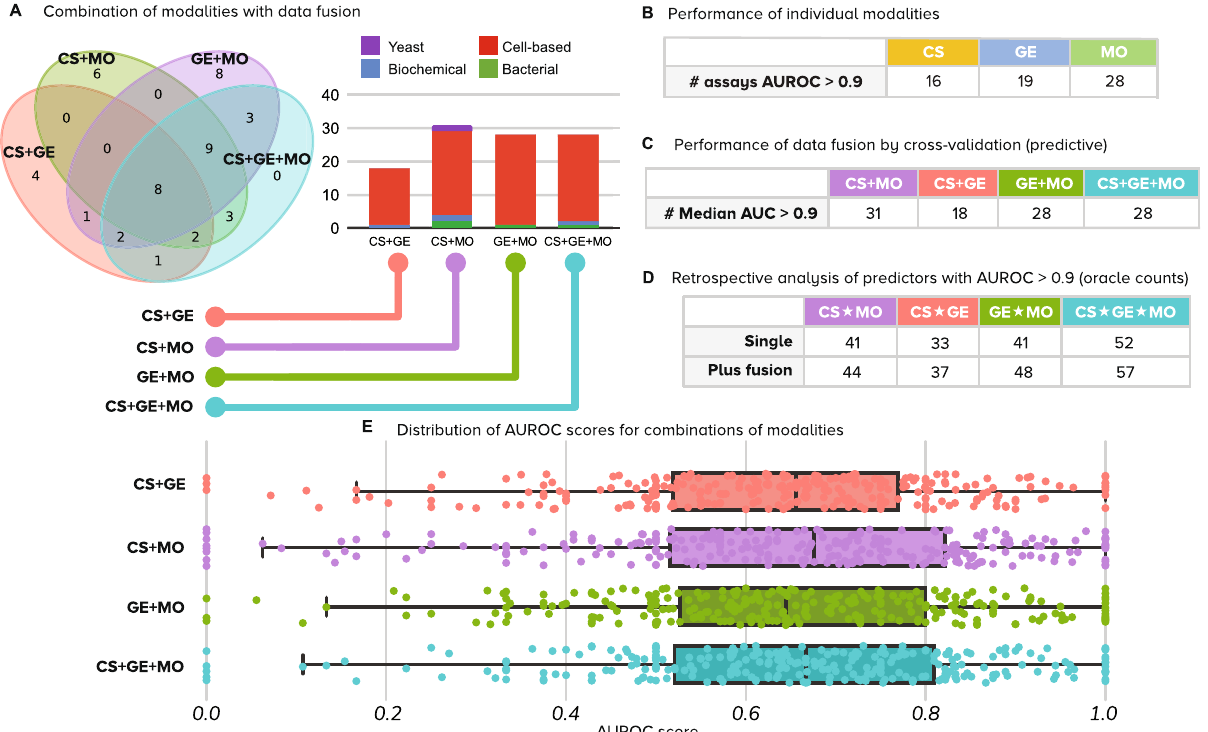
Fig. 3 | Number ofassays that can be accurately predicted using combinations of pro fi ling modalities. Accurate predictors are de fi ned as models with accuracy greater than 0.9 AUROC. We considered all four modality combinations using late datafusioninthisanalysis:CS+MO(chemicalstructuresandmorphology),CS+GE (chemical structures and gene expression), GE+MO (gene expression and mor- phology), and CS+GE+MO (all three modalities). A The Venn diagram shows the numberofaccuratelypredictedassaysthatareincommonoruniquetofused data modalities.Thebarplotsinthecentershowthedistributionofassaytypescorrectly predicted by the fused models. All counts are the median of results in the holdout set of a fi vefold cross-validation experiment. B Performance of individual mod- alities (same as in fi rst row of Fig. 2D). C The number of accurate assay predictors (AUROC>0.9) obtained for combinations of modalities (columns) using late data fusion following predictive cross-validation experiments. D Retrospective perfor- mance of predictors using oracle counts. These counts indicate how many unique assayscanbepredictedwithhighaccuracy(AUROC>0.9),eitherbysingleorfused modalities. “ Single ” is the total number of assays reaching AUROC>0.9 with any